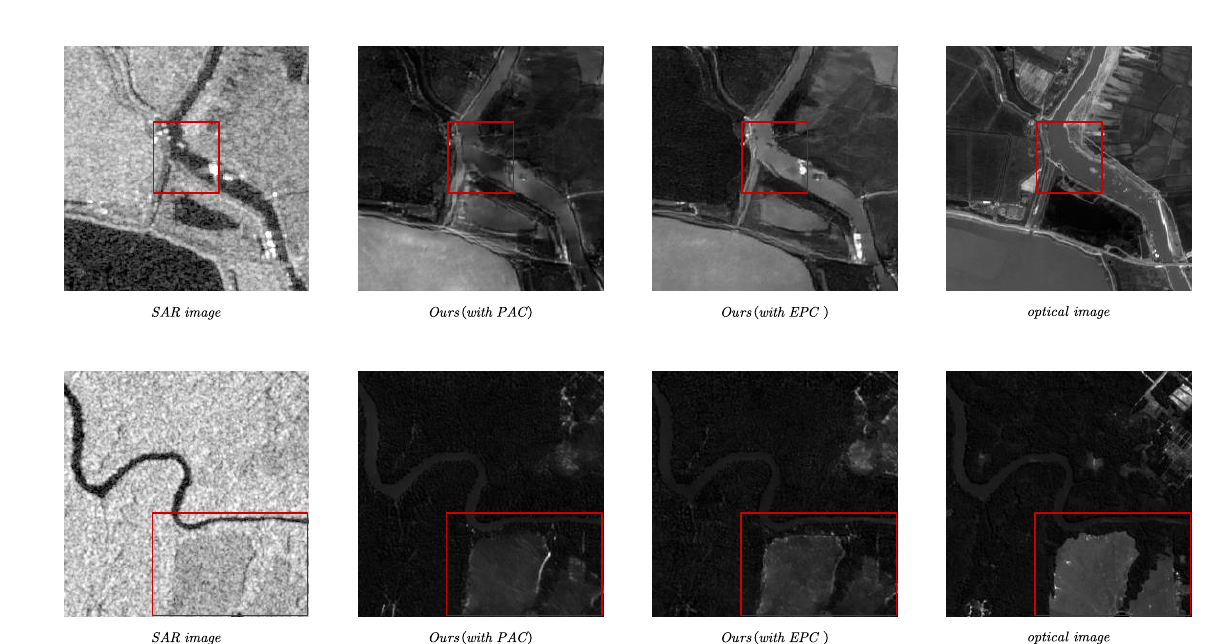
Figure 9. A visual comparison of EPCGAN(PAC) and